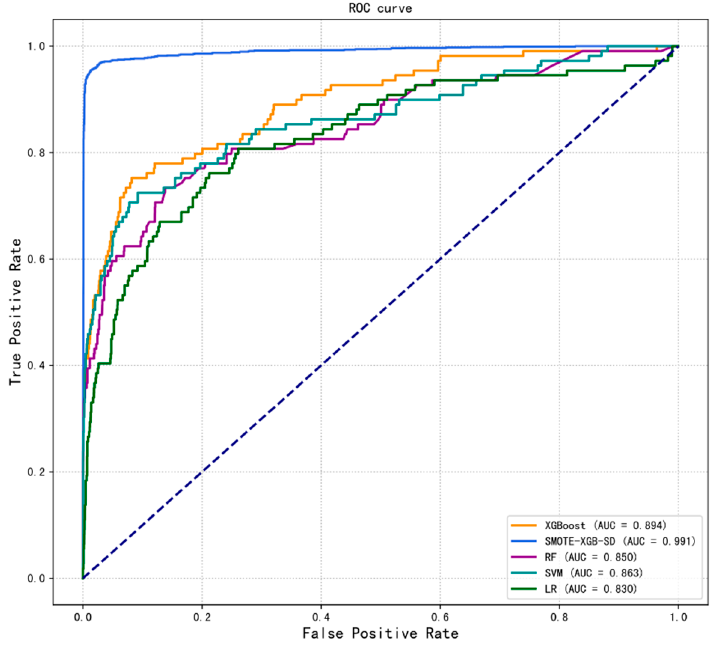
Figure 8. Receiver operating characteristic (ROC) curves of the five classification models.